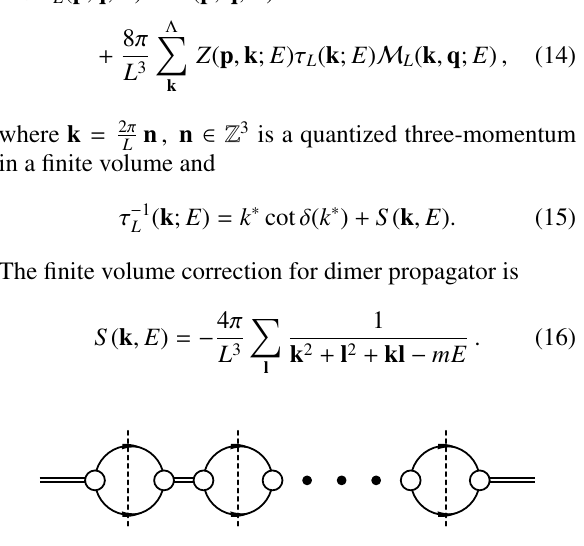
Figure 5: Finite volume correction for dimer propagator